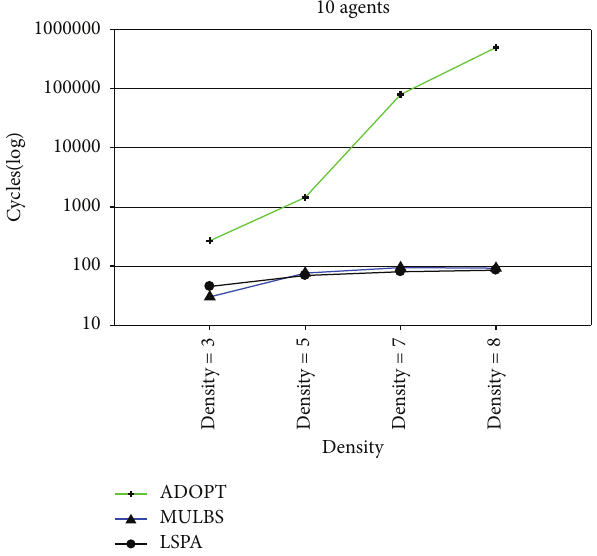
Figure 8: Cycles with 10 agents and densities 3, 5, 7, and 8.